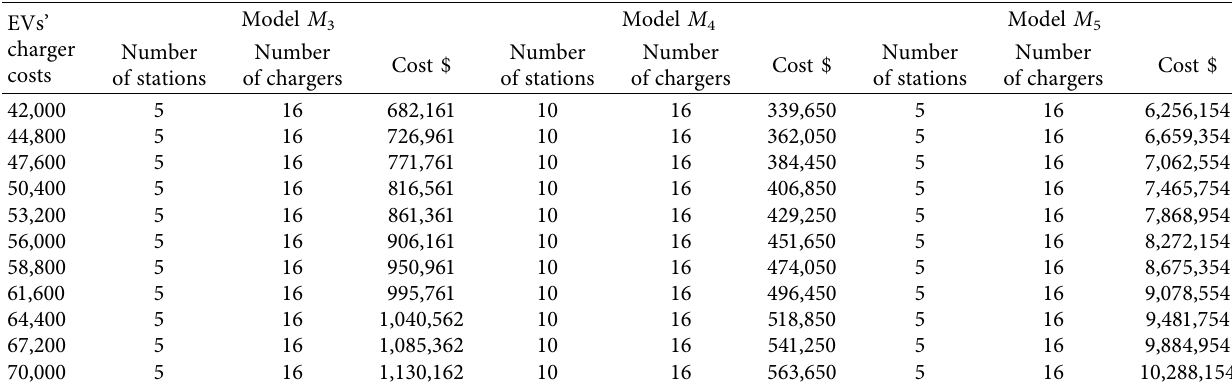
3 , M 4, and M 5 model